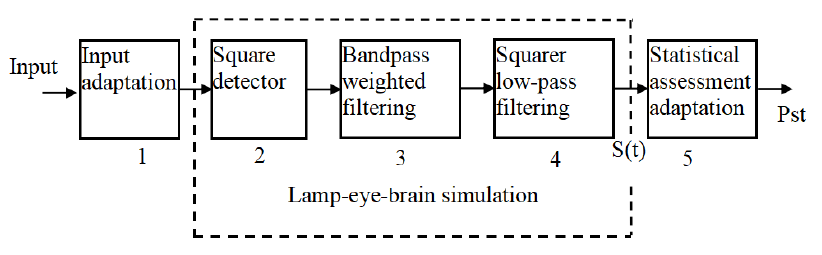
Figure 1. Block diagram of the International Electrotechnical Commission (IEC) flicker detection